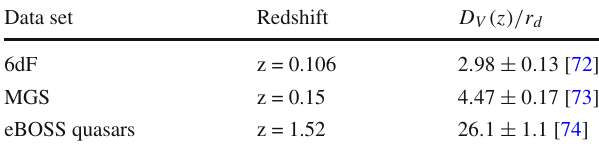
Table 1 The 31 H ( z ) data points [70] Table 2 Isotropic BAO data